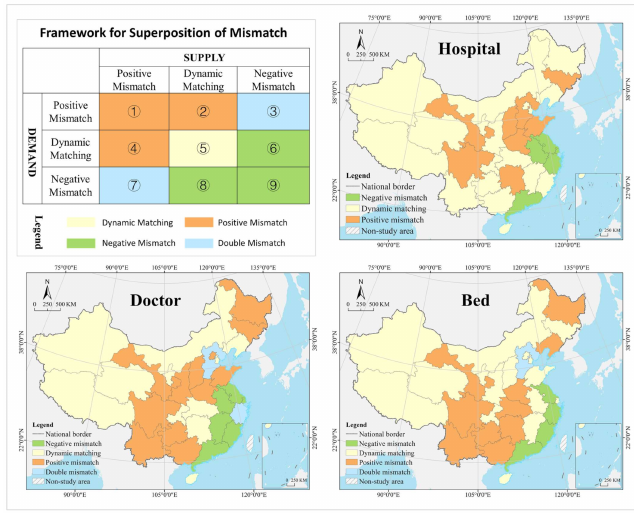
Figure 15. Spatial policy zoning for differentiated